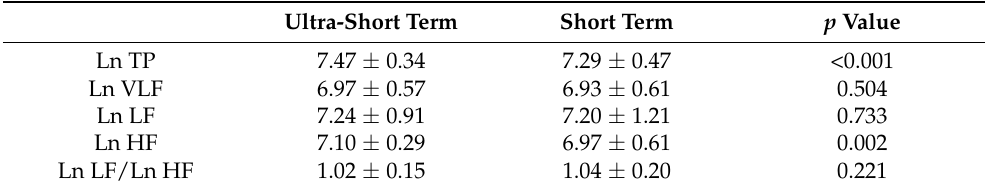
Table 2. Heart rate variability parameters between ultra-short and short term in mild obstructive sleep apnea.